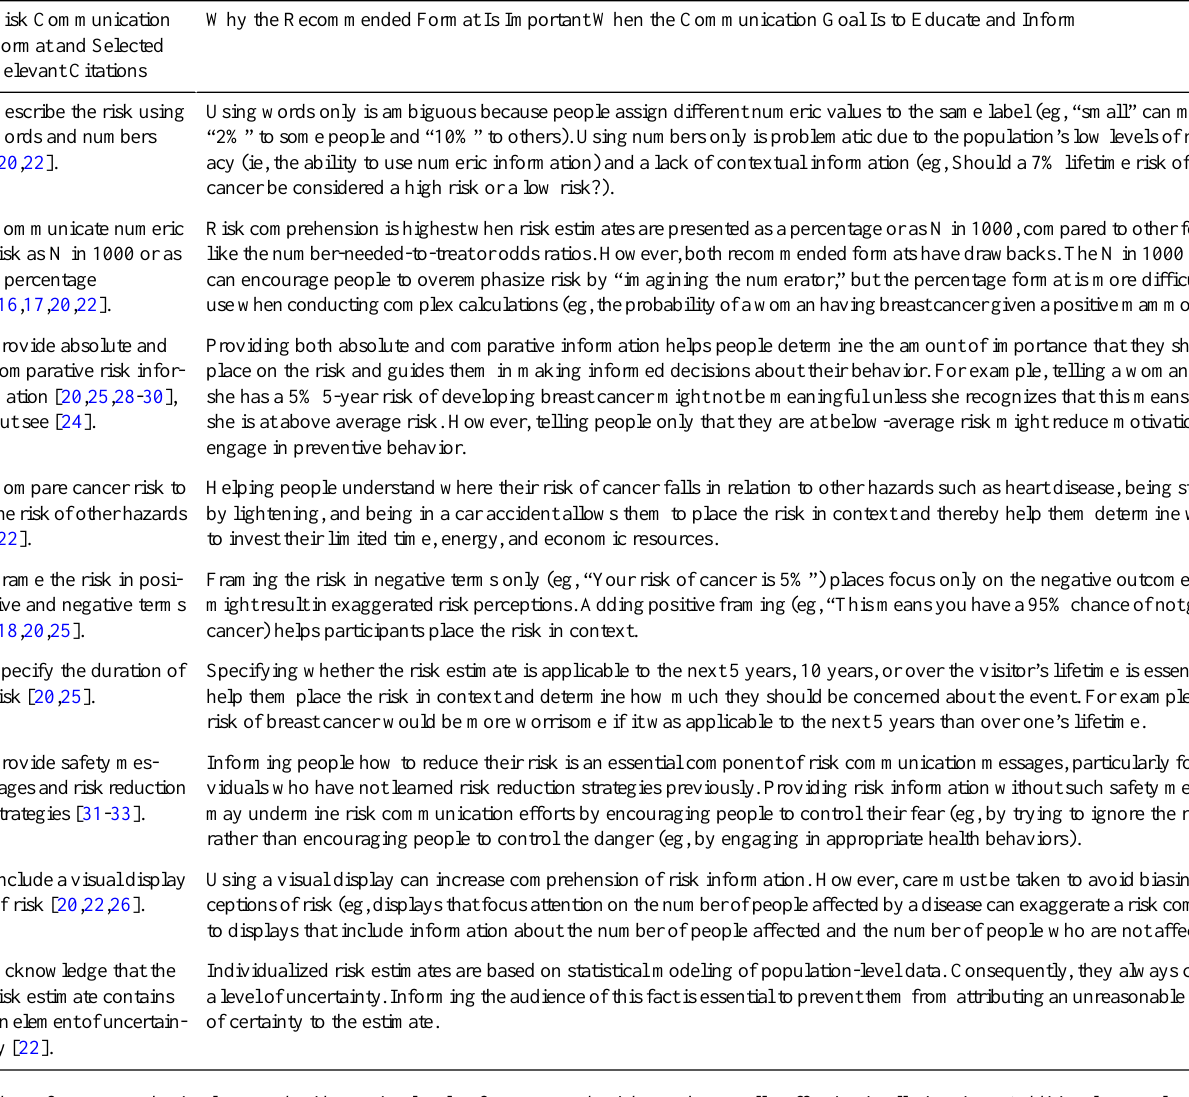
Table 1. Communication formats that reduce bias and facilitate comprehension of probabilistic risk estimates a